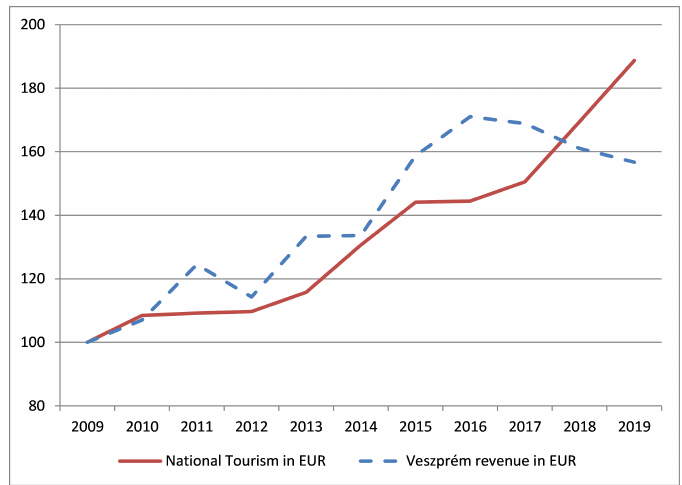
Figure 7: Growth patterns of the total revenues in Euro of commercial accommodation establishments in Hungary and the Veszpr´em district between 2009-2019.